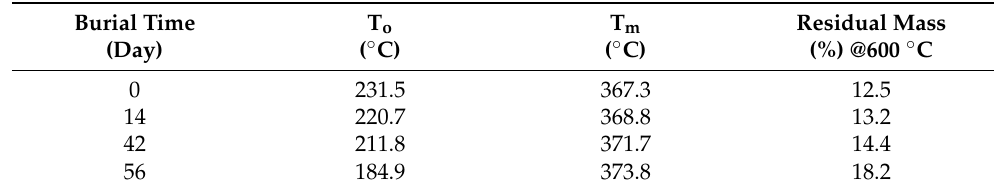
Table 1. Main thermal performance parameters of environment-friendly bamboo fiber lunch box in different degradation stages.